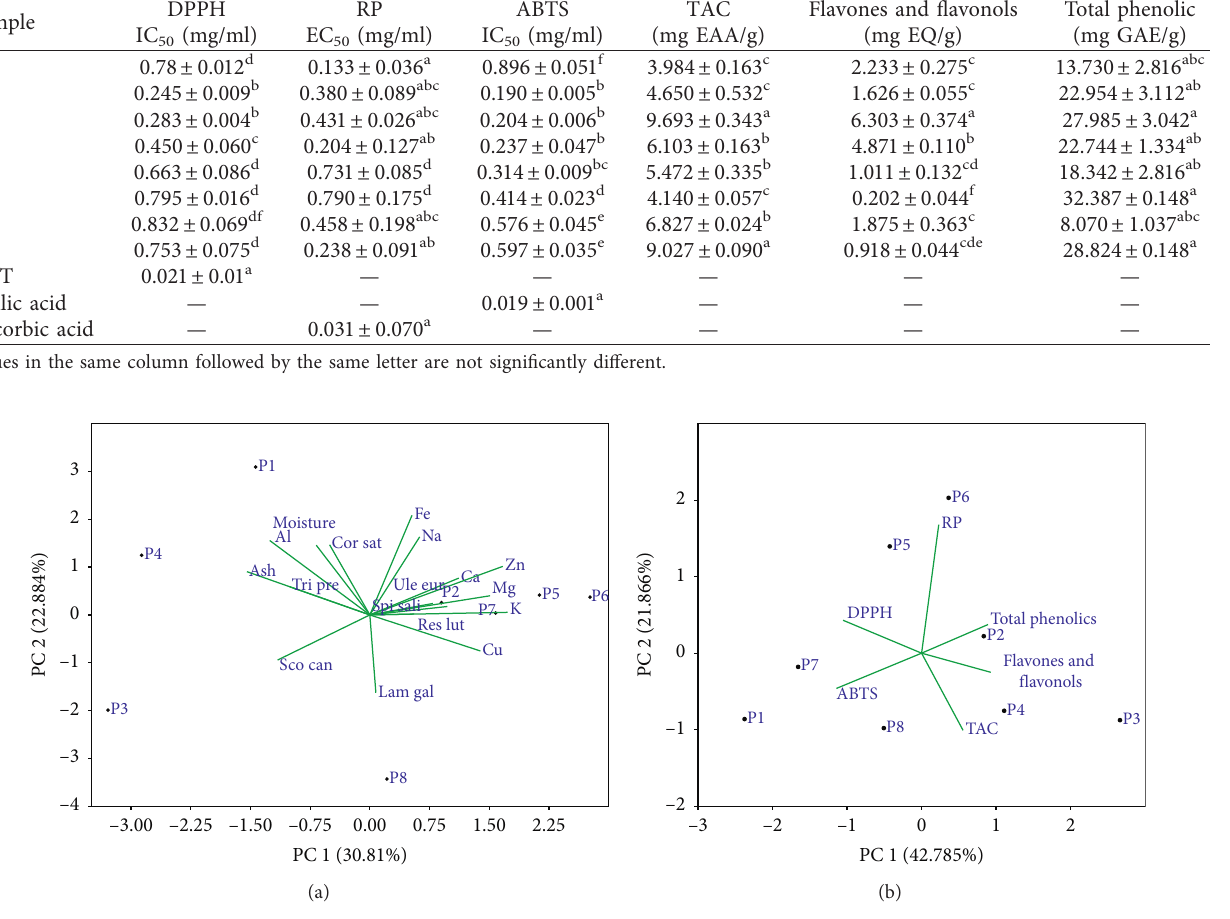
Figure 2: Principal component analysis: (a) biplots of monofloral bee pollen samples using palynological analysis (cor sat: Coriandrum sativum ; ule eur: Ulex europaeus ; sco can: Scorzonera cana ; tri pre: Trifolium pretense ; res lut: Reseda luteola ; spi sal: Spiraea salicifolia ; and lam gal: Lamium galeobdolon ), mineral content, ash, and moisture; (b) biplots of monofloral bee pollen using total phenolic, flavones/ flavonols, total antioxidant activity, and the antioxidant activities(ABTS, RP, and